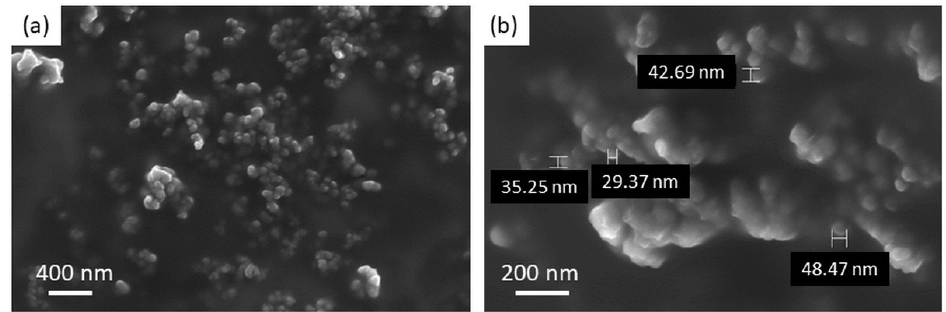
Figure 5. ( a , b ) SEM micrographs of alginate nanoparticles.